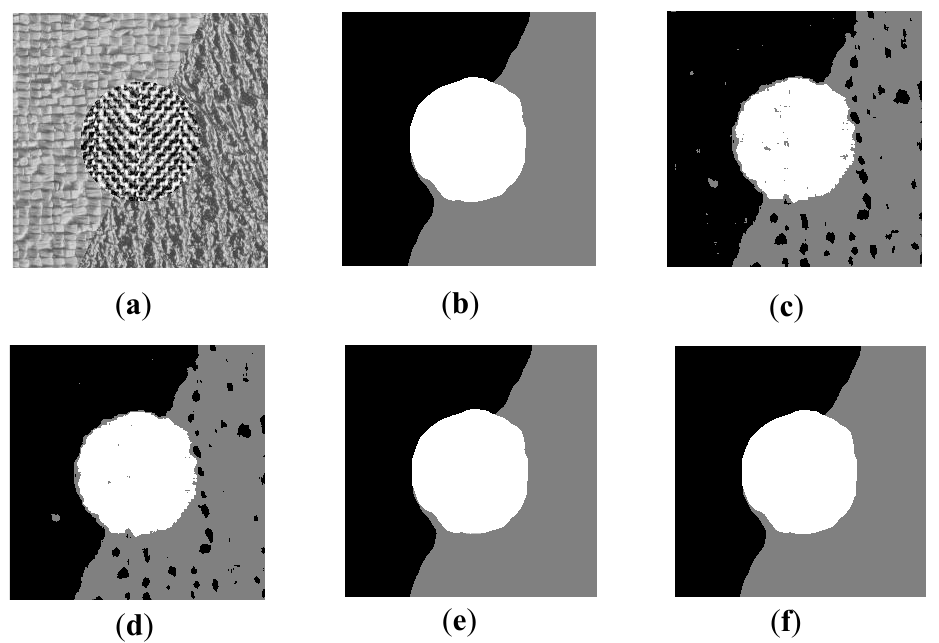
Figure 20. Segmentation results of five different feature weights on Image5. ( a ) original image; ( b ) the weight of weight determination layer; ( c ) w = − 20; ( d ) w = − 10; ( e ) w = 10; ( f ) w = 20.